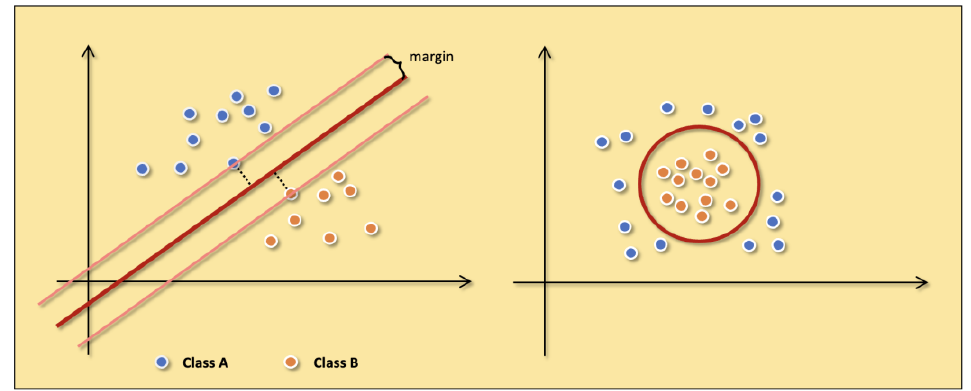
Figure 7. The examples of linearly divisible samples (the left figure) and linearly indivisible samples (the right figure). Class A (blue points) and Class B (orange points) represent two different samples. ( the right figure ). Class A (blue points) and Class B (orange points) represent two different